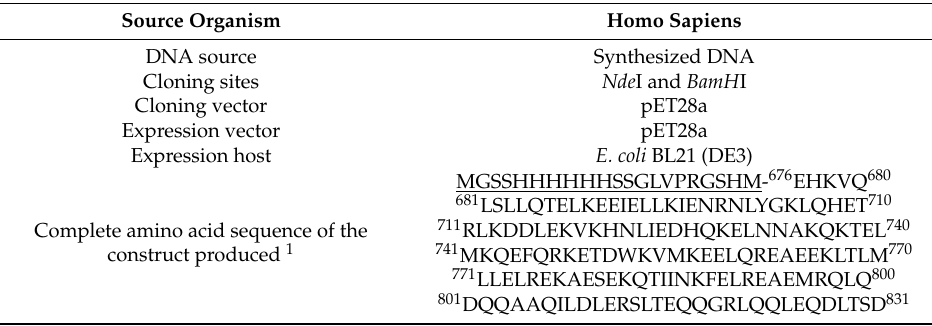
Table 1. Macromolecule production information for PCNT CC2.